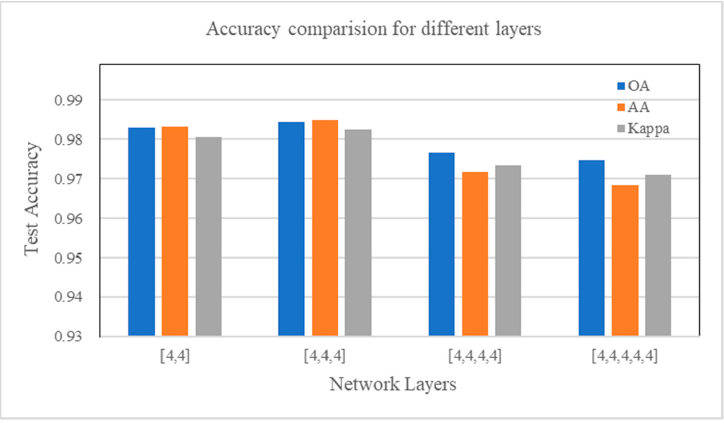
Figure 13. Overall accuracy, average accuracy, and Kappa of different cube spatial sizes.